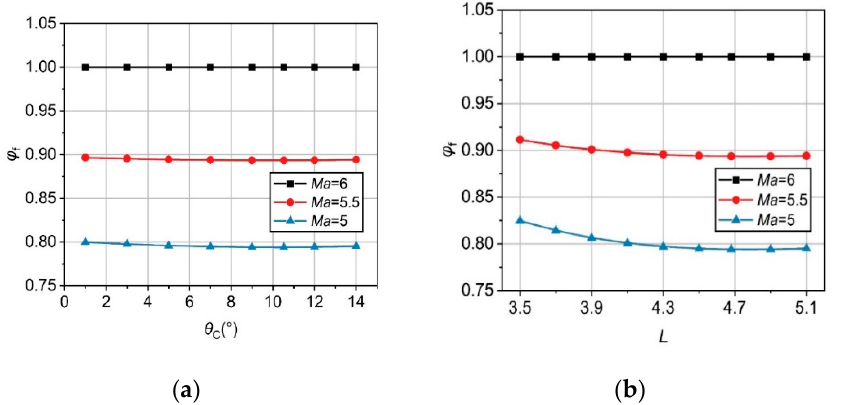
Figure 7. Evolution of the mass capture ratio at off-design Mach numbers with varying ( a ) the cowl internal angle; and ( b ) the inlet